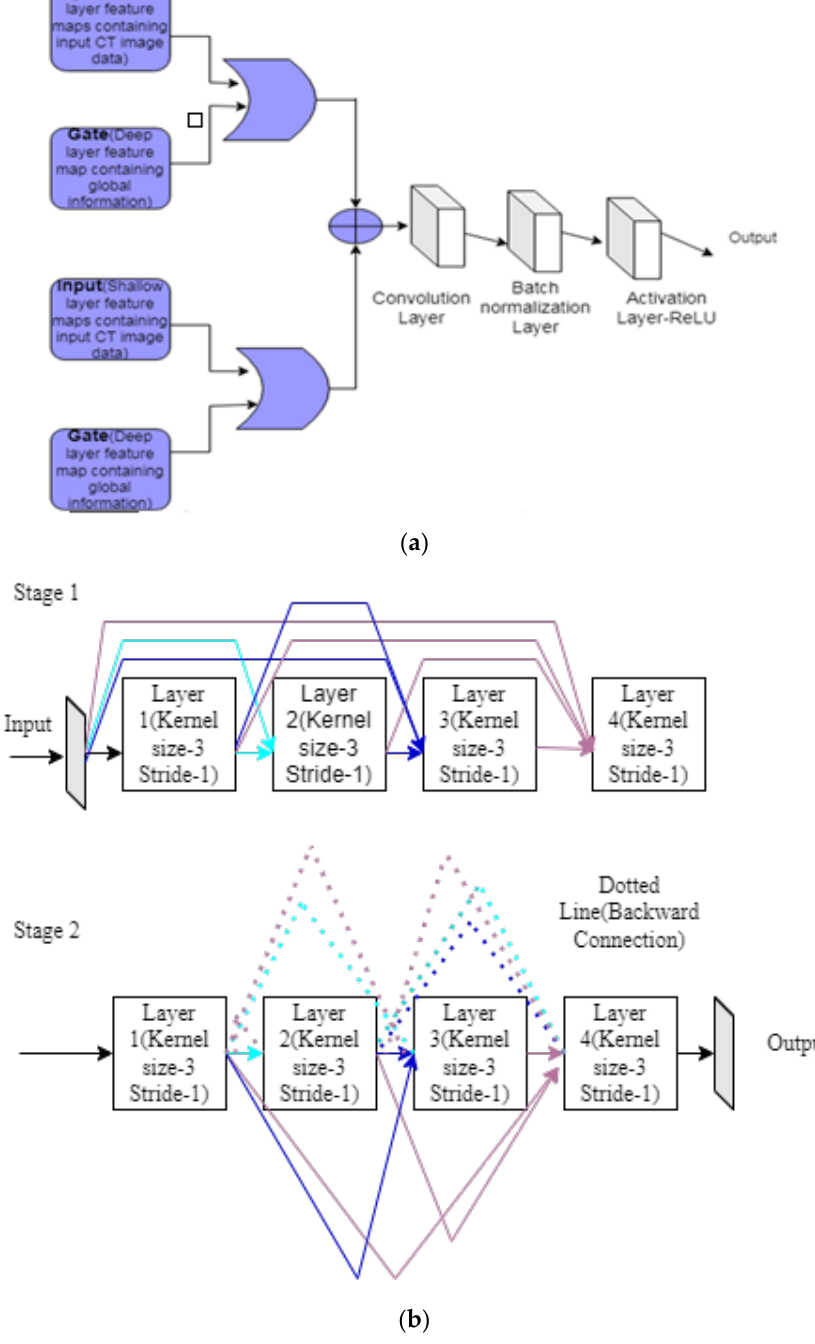
Figure 15. ( a ) Attention mechanism ( b ) U-clique